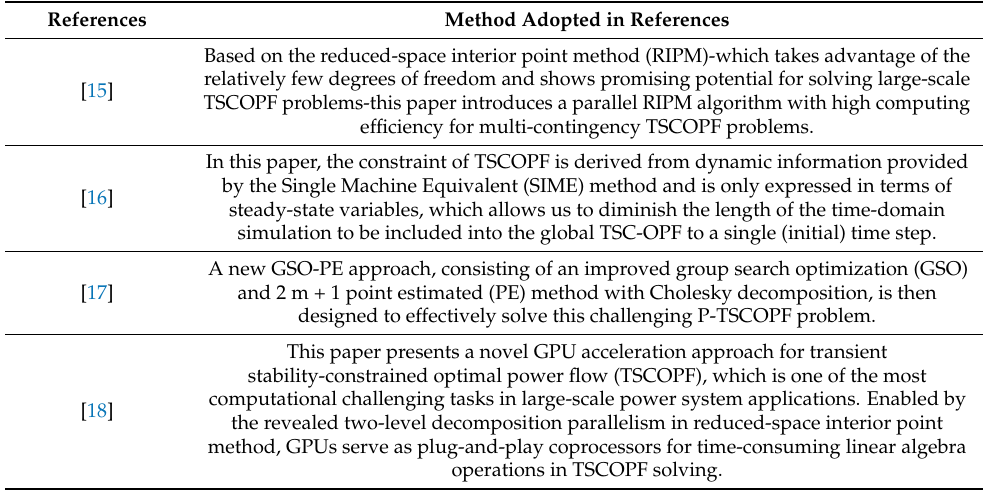
Table 1. Review of existing research